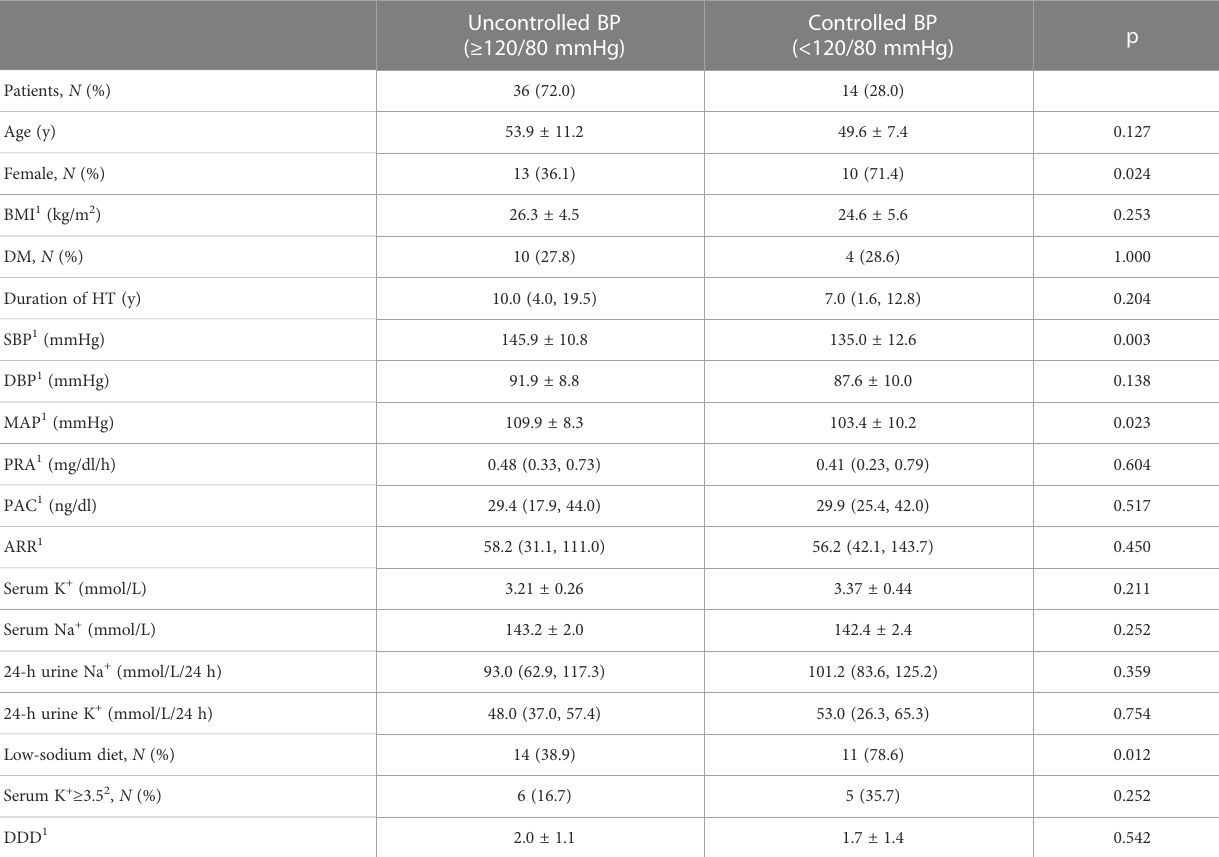
TABLE 4 Demographic and clinical characteristics of patients with controlled and uncontrolled BP after the dietary